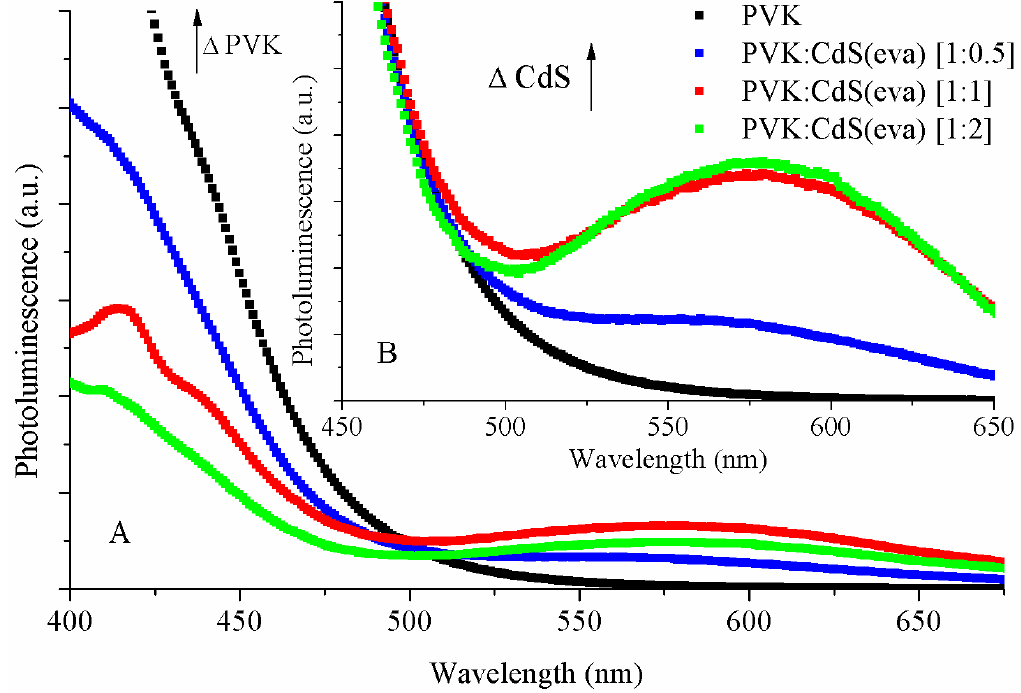
Figure 10. ( A ) The photoluminescence spectra and ( B ) the normalized PL spectra of the solutions: PVK (black), PVK:CdS(eva) [1:0.5] (blue), PVK:CdS(eva) [1:1] (red) and PVK:CdS(eva) [1:2] (green).